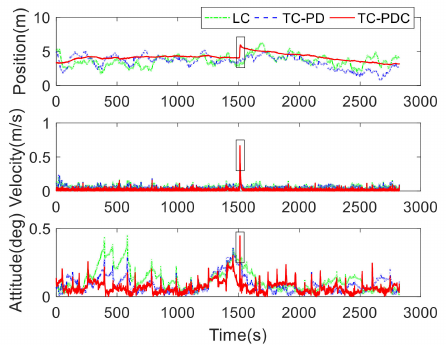
Figure 6. Navigation errors of loose coupling (LC), tight coupling based on pseudorange and Doppler (TC-PD), and tight couple based on pseudorange, Doppler, and carrier phase (TC-PDC). Table 3. Root-mean-square errors (RMSE) comparison among LC, TC-PD, and TC-PDC. Position